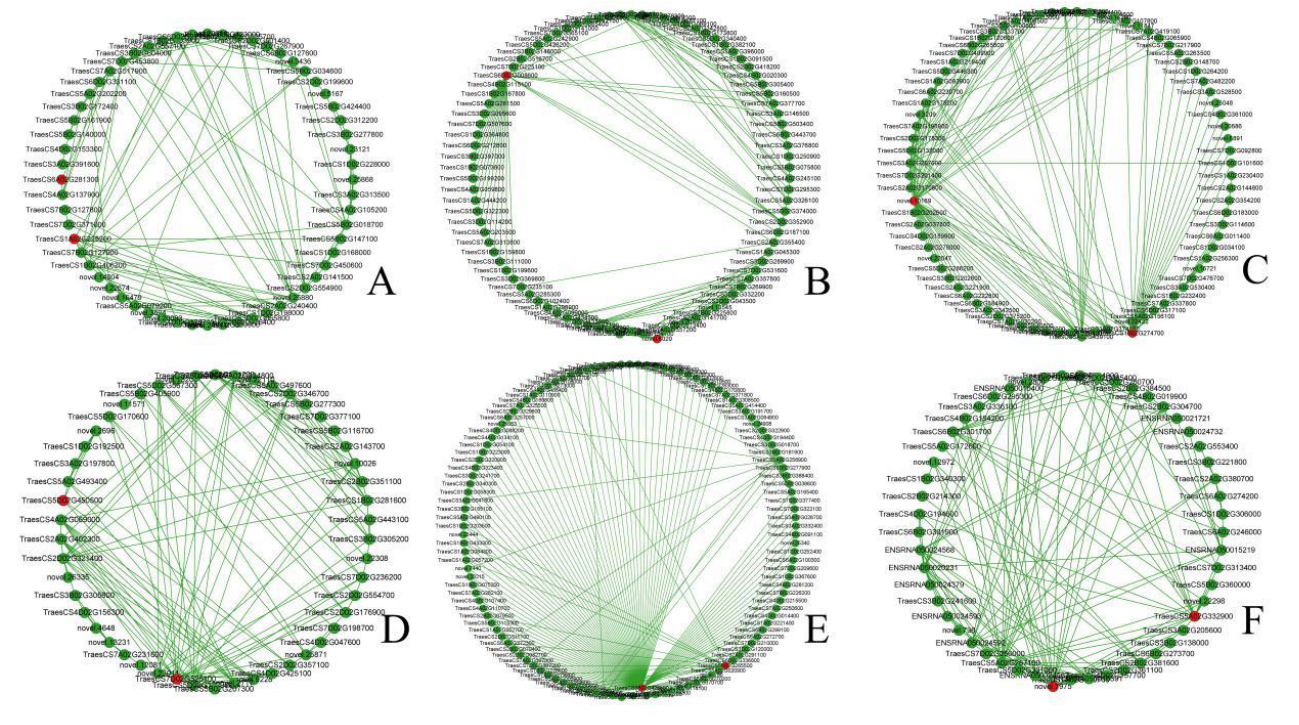
Figure 6. Identification of hub genes in the six interested modules. ( A ) The hub genes of the Midnight- blue module are TraesCS1A02G225200 and TraesCS6A02G281300 . ( B ) The hub genes of the Blue module are novel.8020 and TraesCS6D02G008600 . ( C ) The hub genes of the Brown module are novel.10169 and TraesCS1B02G274700 . ( D ) The hub genes of the Lightcyan module are TraesCS5D02G450500 and TraesCS7D02G526100 . ( E ) The hub genes of the Turquoise module are TraesCS5D02G265500 and TraesCS5B02G426500 . ( F ) The hub genes of the Tan module are TraesCS5A02G332900 and novel.7975 . The top 150 linked genes of the module were analyzed and visualized, and the top 2 genes in each module were selected as hub genes according to the degree of gene